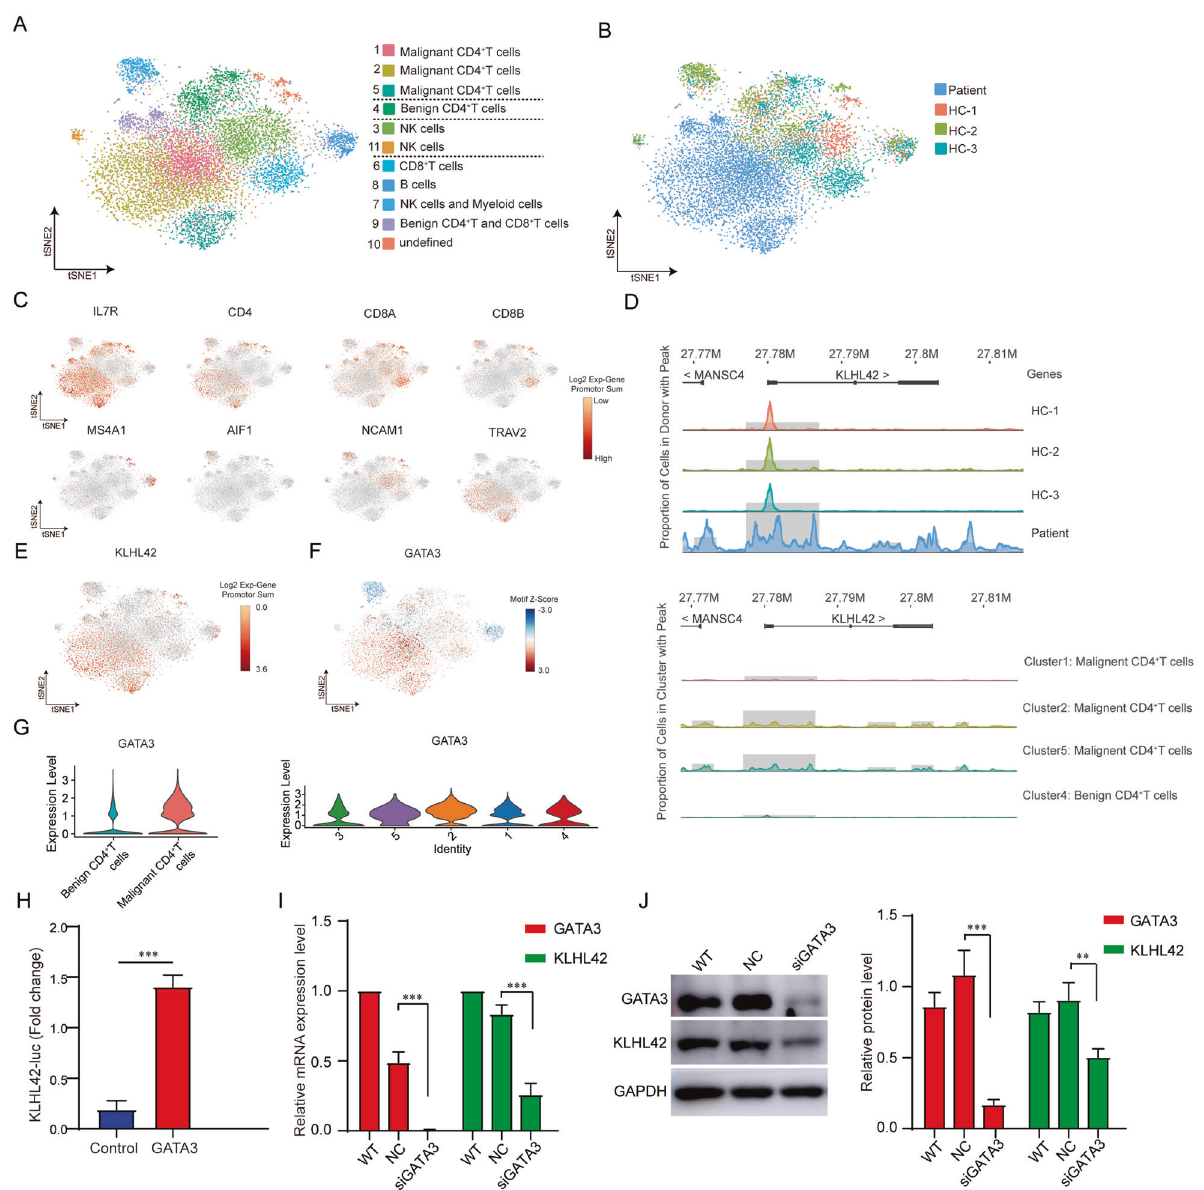
Fig. 5 ScATAC-seq revealed KLHL42 -associated transcriptional regulatory mechanism in malignant CD4 + T cells. A t-SNE projection of scATAC-seq pro fi les from PBMCs of the SS patient and three HCs. B t-SNE plot for PBMC CD4 + T cells split by the SS patient and HCs. C Expression of marker genes for major cell types. D Genome tracks of scATAC-seq data at the KLHL42 locus in the SS patient and HCs. And genome tracks of scATAC-seq data at the KLHL42 locus in benign CD4 + T cells (Cluster 4) and malignant CD4 + T cells (Cluster1, 2, 5). Highlighted regions showing cell type-speci fi c ATAC-seq peaks. E t-SNE projection colored by log2 Exp-gene promoter sum demonstrating the chromatin accessibility of KLHL42 . F t-SNE projection colored by chromVAR deviation z-score of TF motif demonstrating the acvivity of GATA3 . G The former showing the expression of GATA3 in benign (clusters 1, 4, 6, 7, 8, 9, 12, 14) and malignant (clusters 2, 3, 5, 10, 13) CD4 + T cells, clustering referred to Fig. 1C. And the later showing the expression of GATA3 in benign (cluster 3), intermediate (cluster 5), and malignant (clusters 1, 2, 4) CD4 + T cells, clustering referred to Fig. 4D. H Dual-luciferase reporter assays showing that GATA3 overexpression increased the luciferase activity in HEK293T cells transfected with the KLHL42 promoter plasmid. I , J The mRNA and protein levels of GATA3 and KLHL42